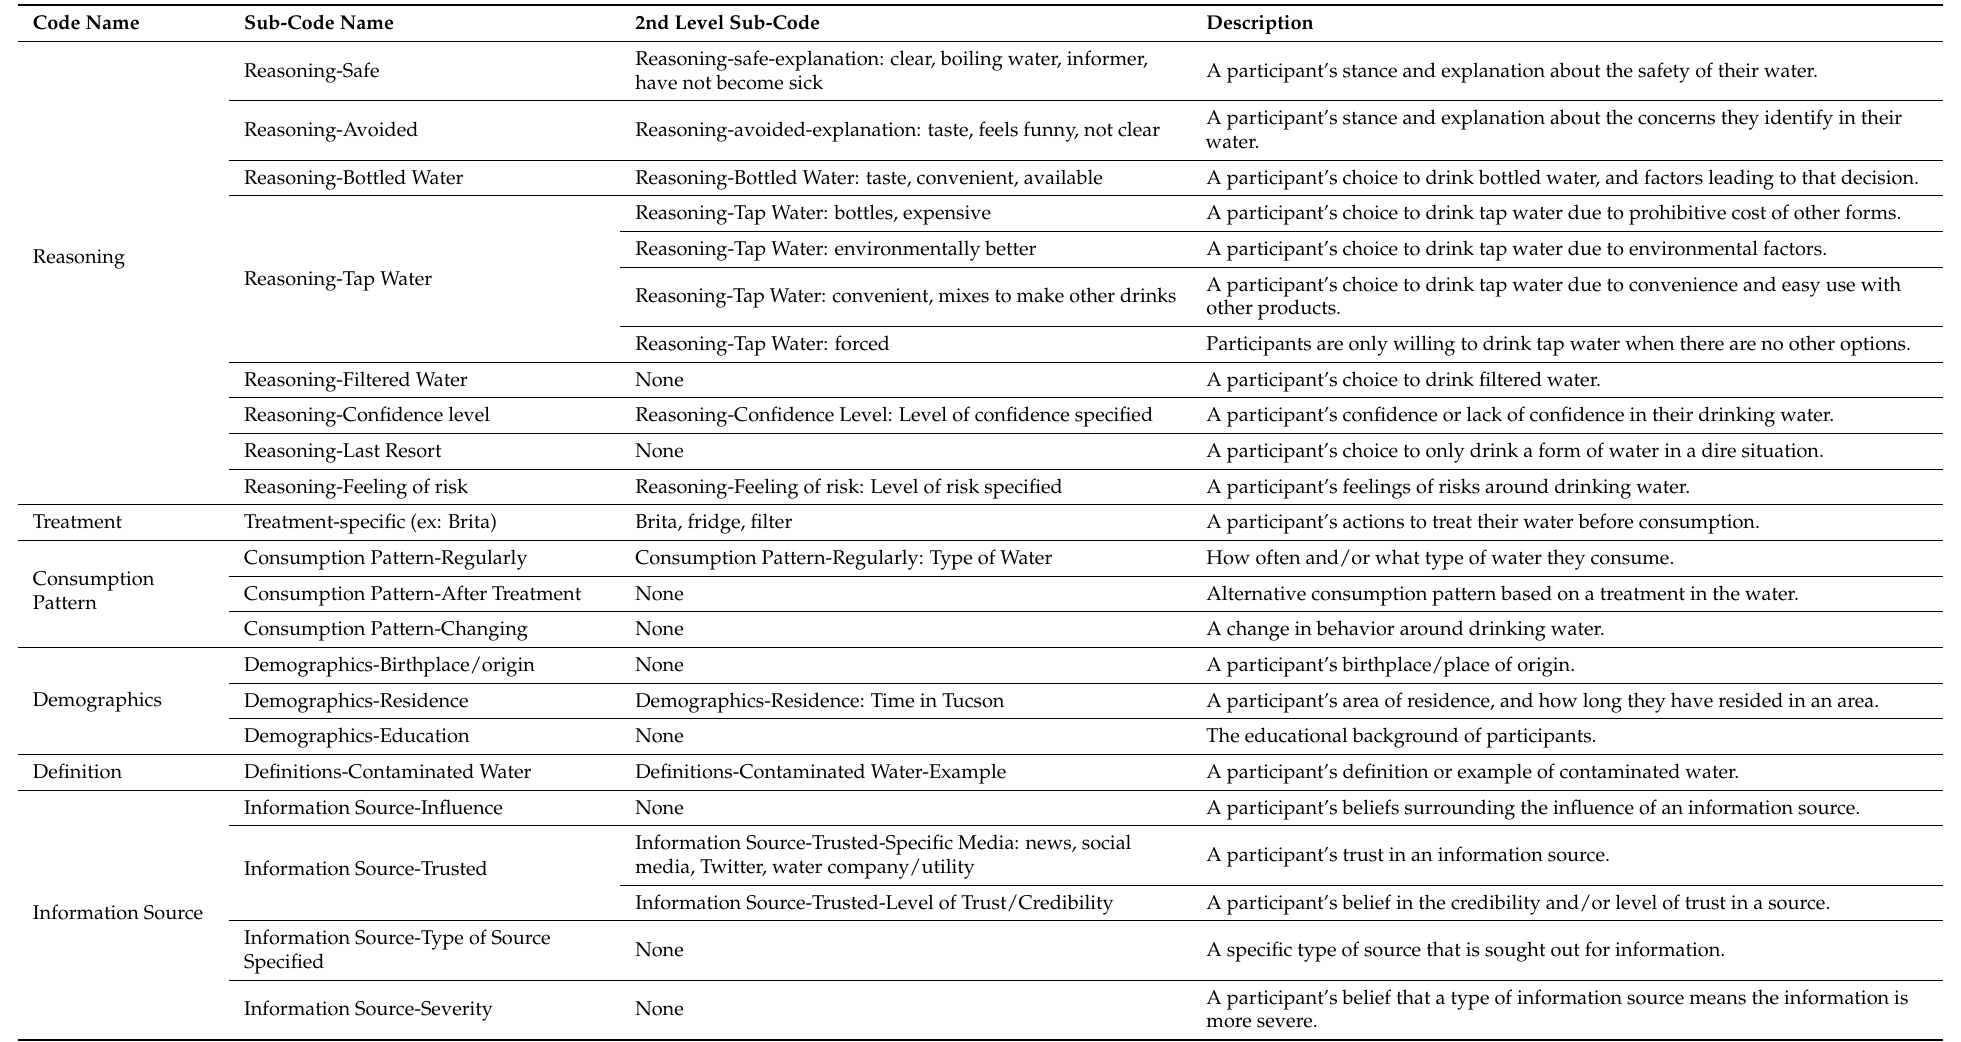
Table 1. List of